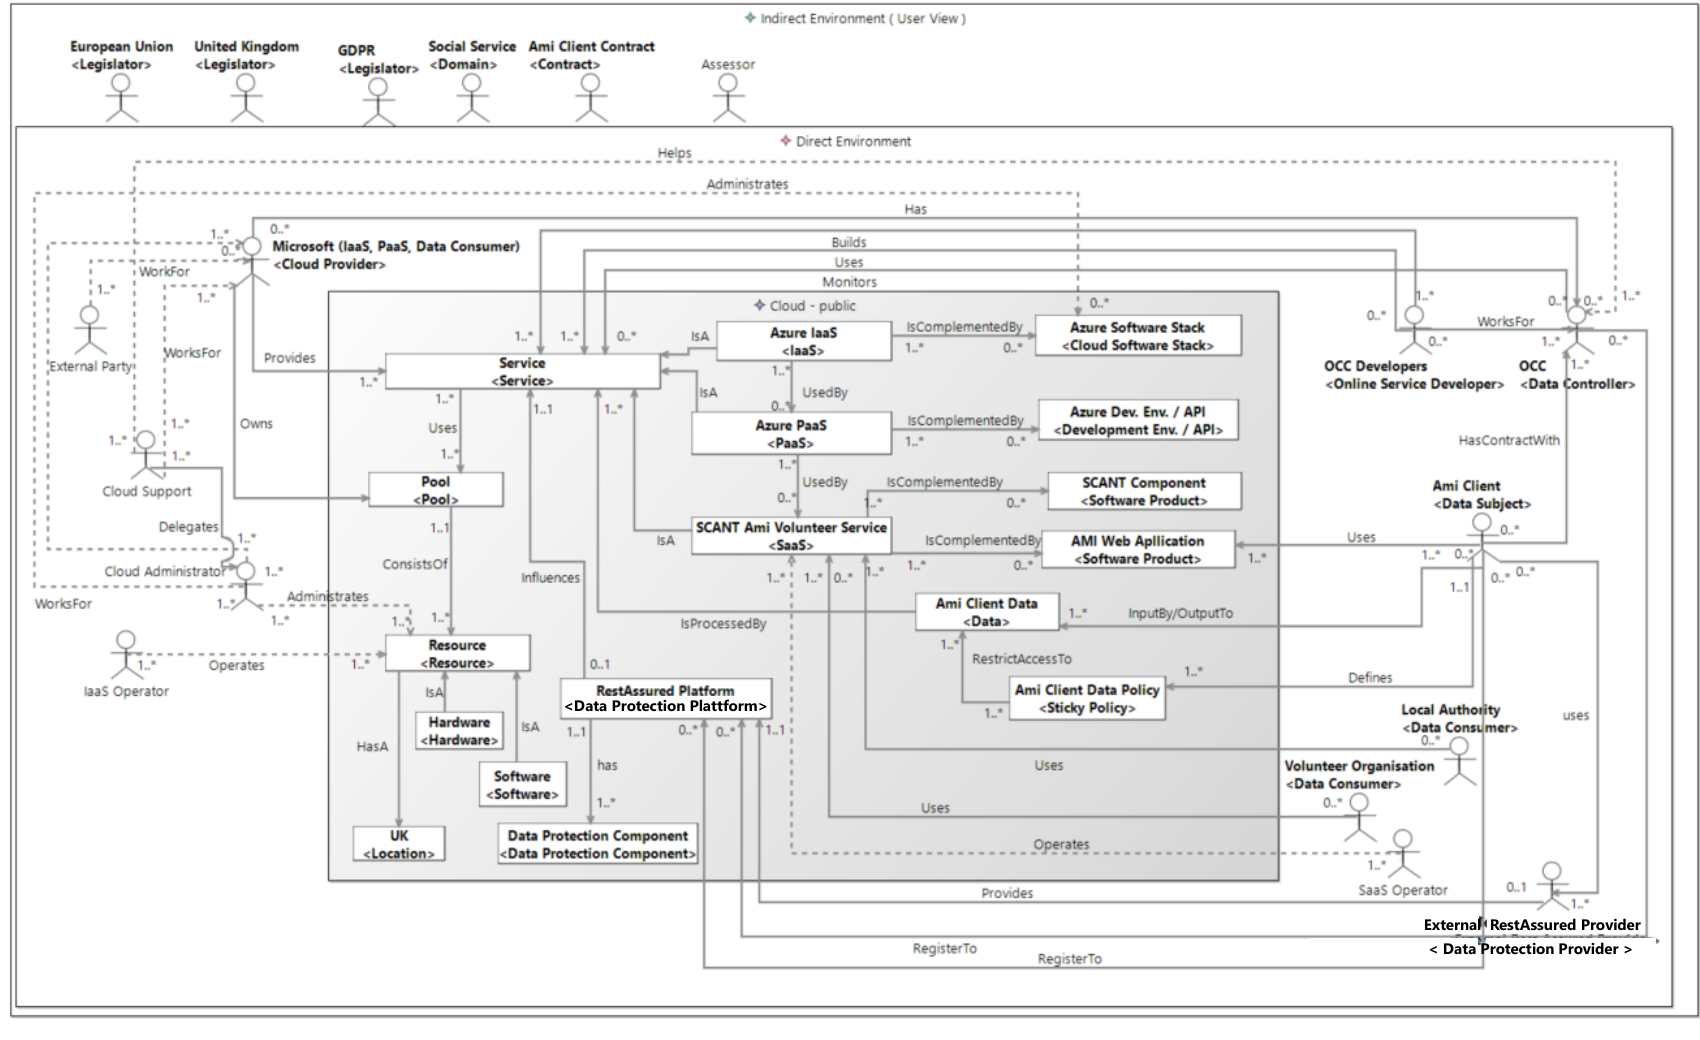
Figure 4. Instantiation of the ReAs-CSAP for the use case Ami volunteer service with the additional SCANT component